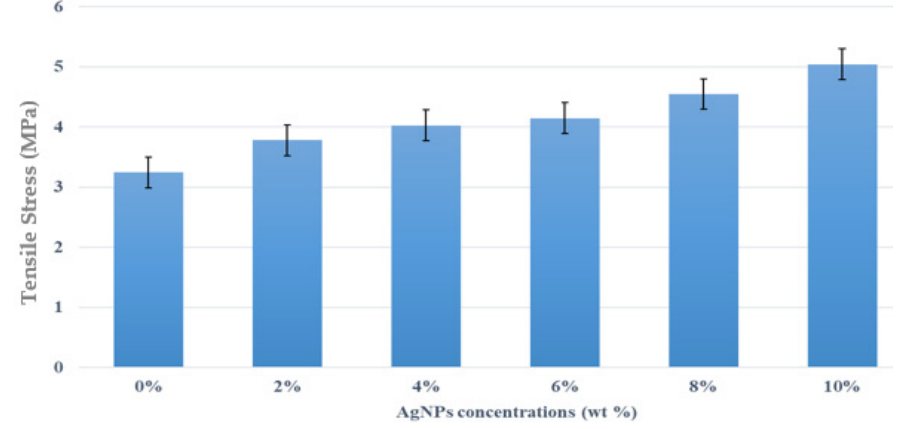
Figure 5. Effects of AgNP content on tensile stress of kenaf/HDPE composites.